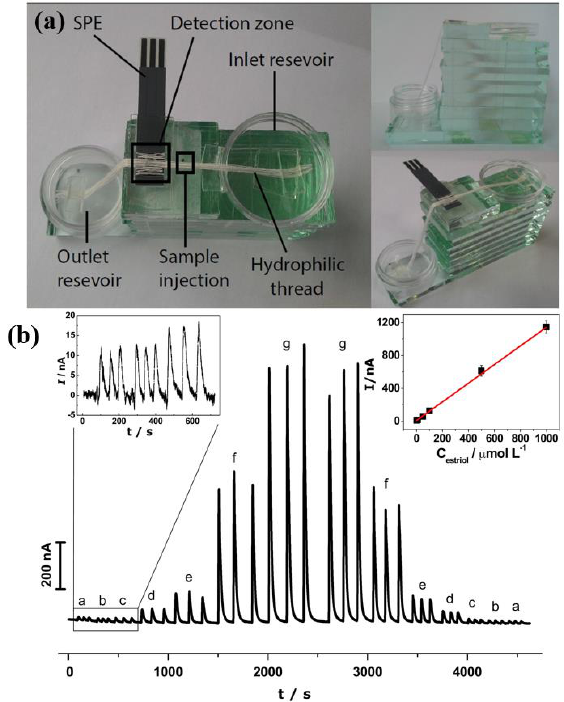
Figure 8. ( a ) Illustration of the thread-based electroanalytical device after the assembly process. ( b ) Successive amperometric response in µ TED obtained from injections of 2.0 µ L of estriol standard solutions aliquots, varying over a range of (a) 1.0; (b) 5.0; (c) 10.0; (d) 50.0; (e) 100.0; (f) 500.0 and (g) 1000.0 µ mol L − 1 , with a flow rate of 0.50 µ L s − 1 . Applied potential: 0.75 V. Analytical curve